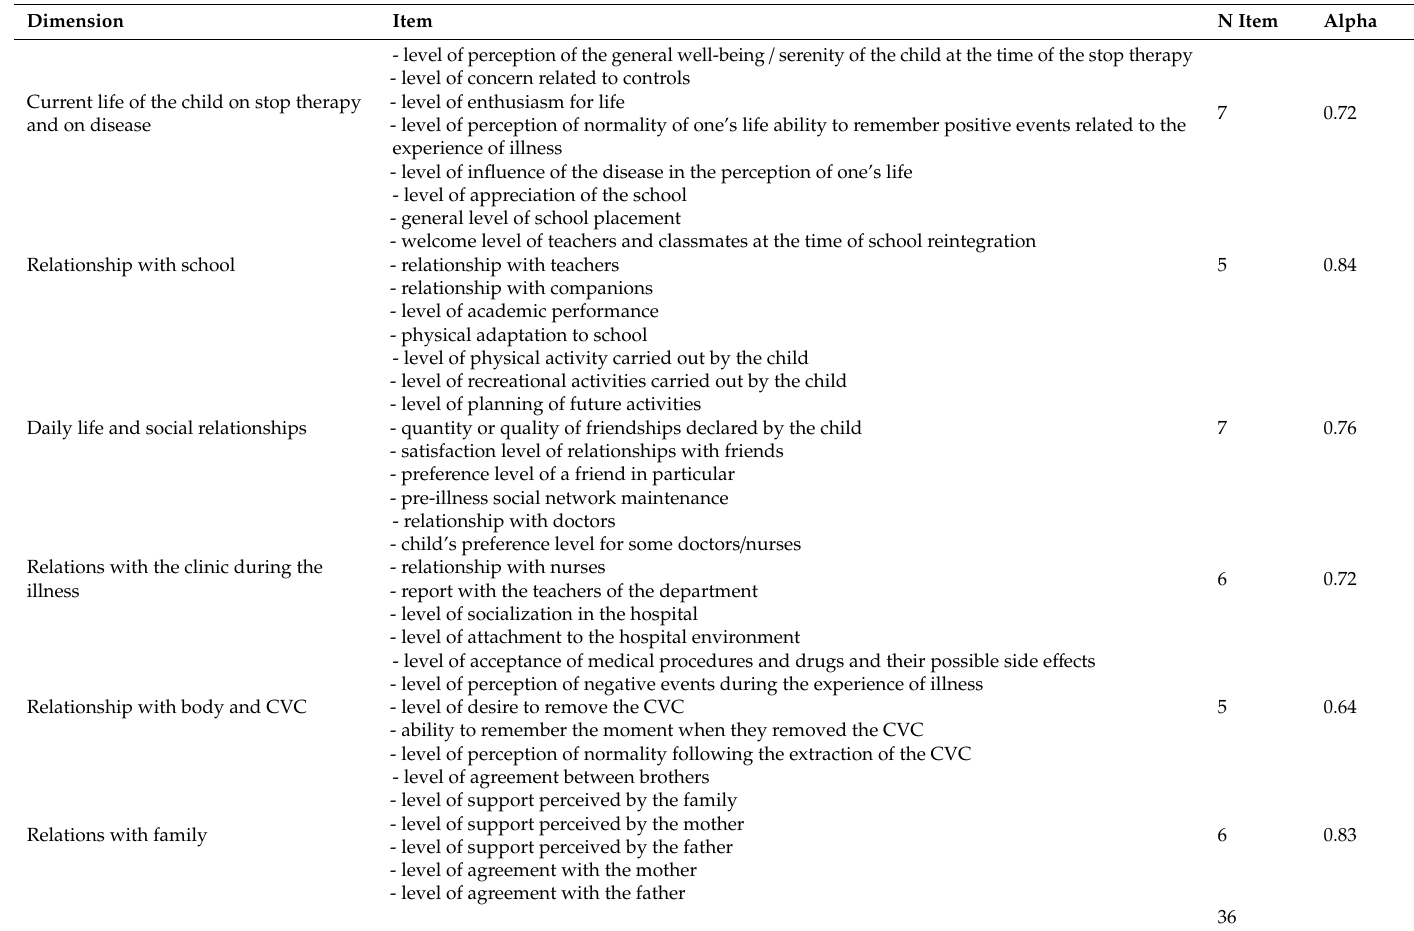
Table 3. Cronbach explanation, item grouping and Alpha values for Ecocultural Family Interview (EFI) -Cancer (EFI-C) dimensions.